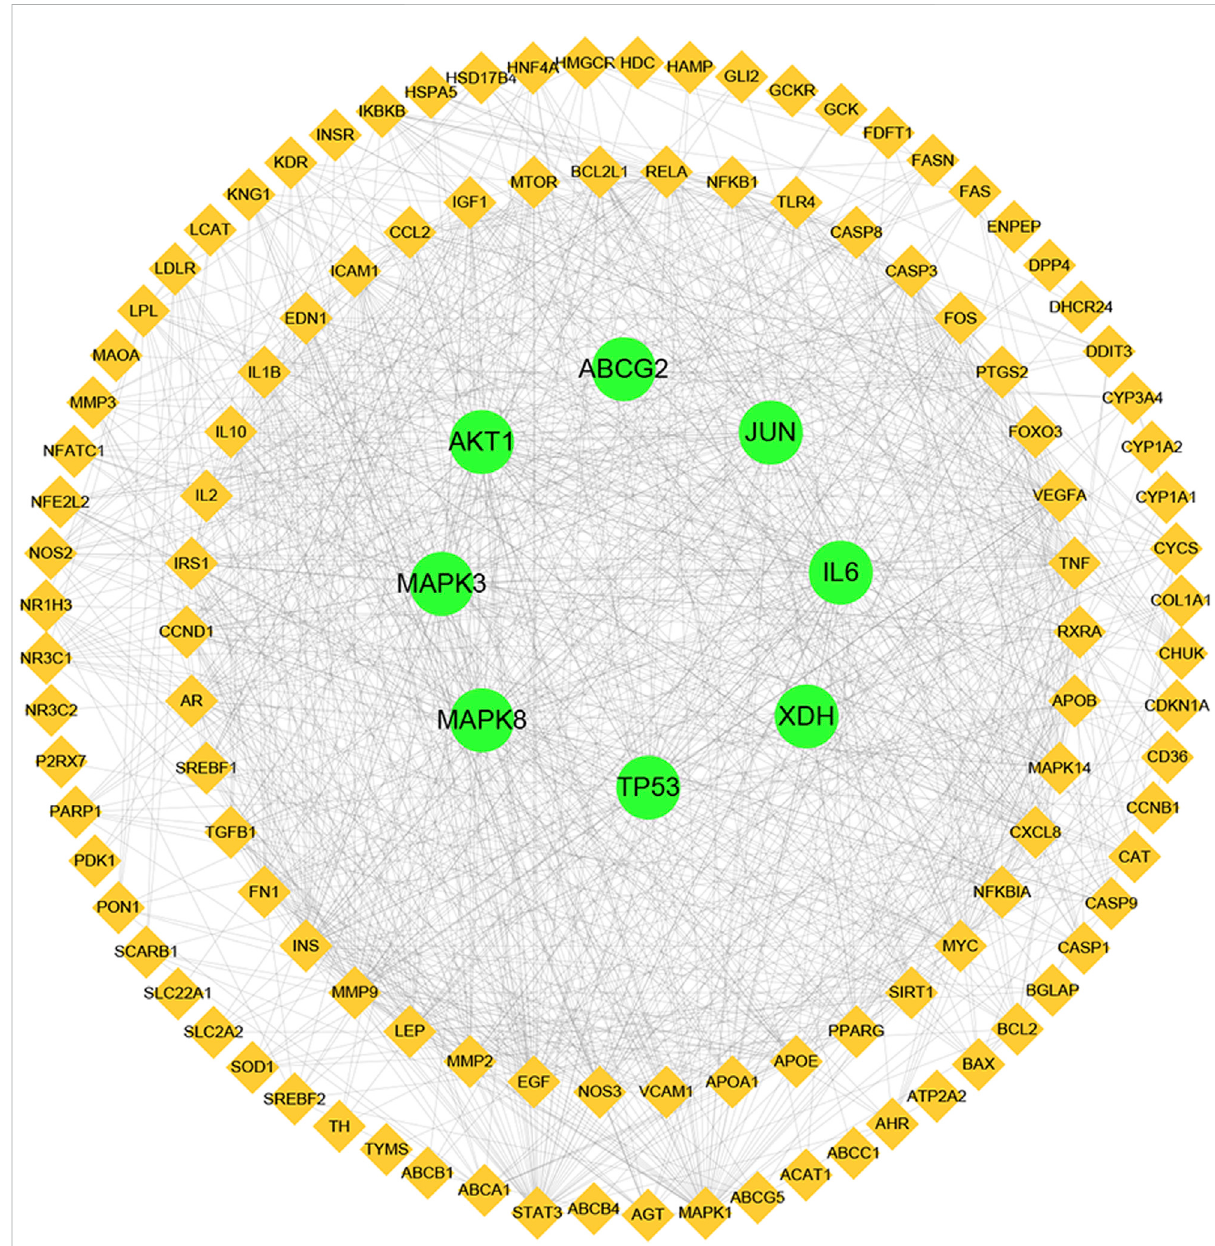
FIGURE 4 Protein – protein interaction (PPI) network analysis of CP for the treatment of HUA using STRING